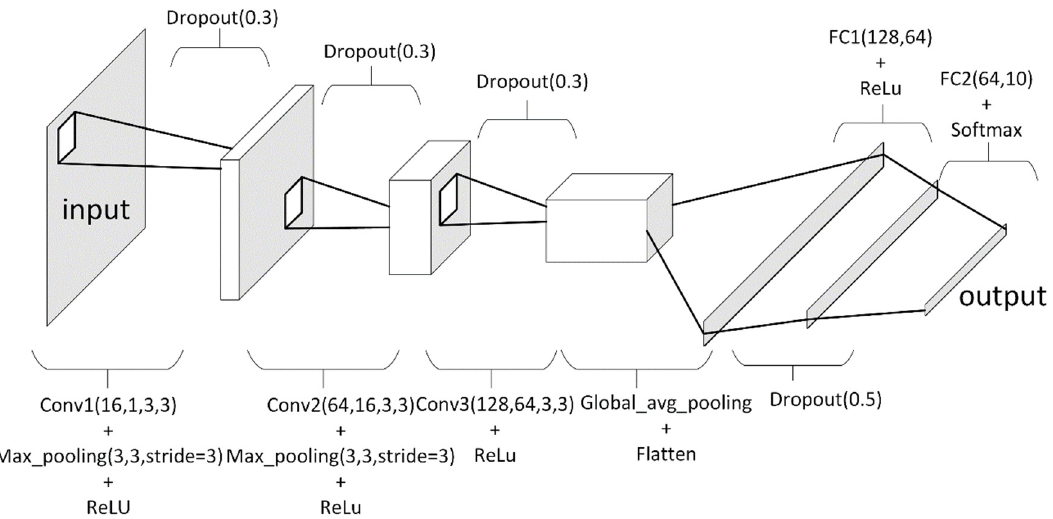
Figure 1. Deep Convolutional Neural Network model for environmental sound classification with fractional-order calculus-based data augmentation experiments.